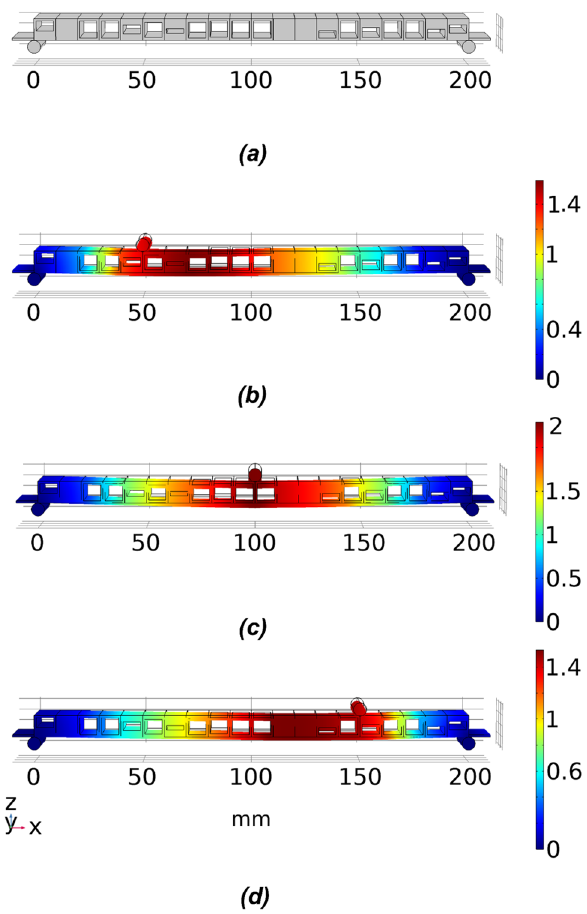
Figure 16. An example of the optimised 20 voxels asymmetric single void beam model for target set TS1. ( a ) The geometry of the optimised beam model, and ( b – d ) is the deflection under loading conditions 1–3.